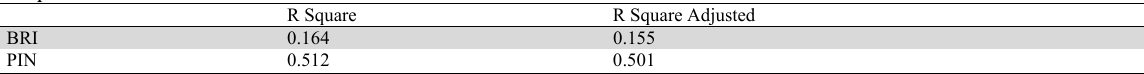
R-Square Value R Square R Square Adjusted BRI 0.164 0.155 PIN 0.512 0.501